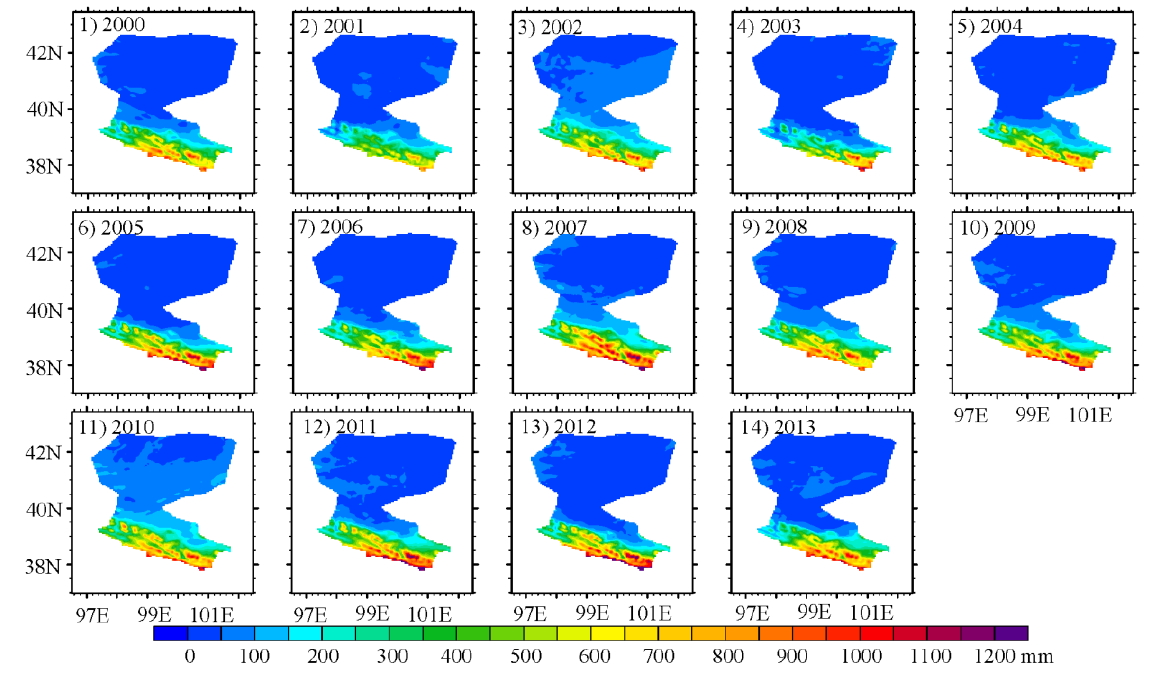
Figure 6. Annual precipitation over the HRB from 2000 to